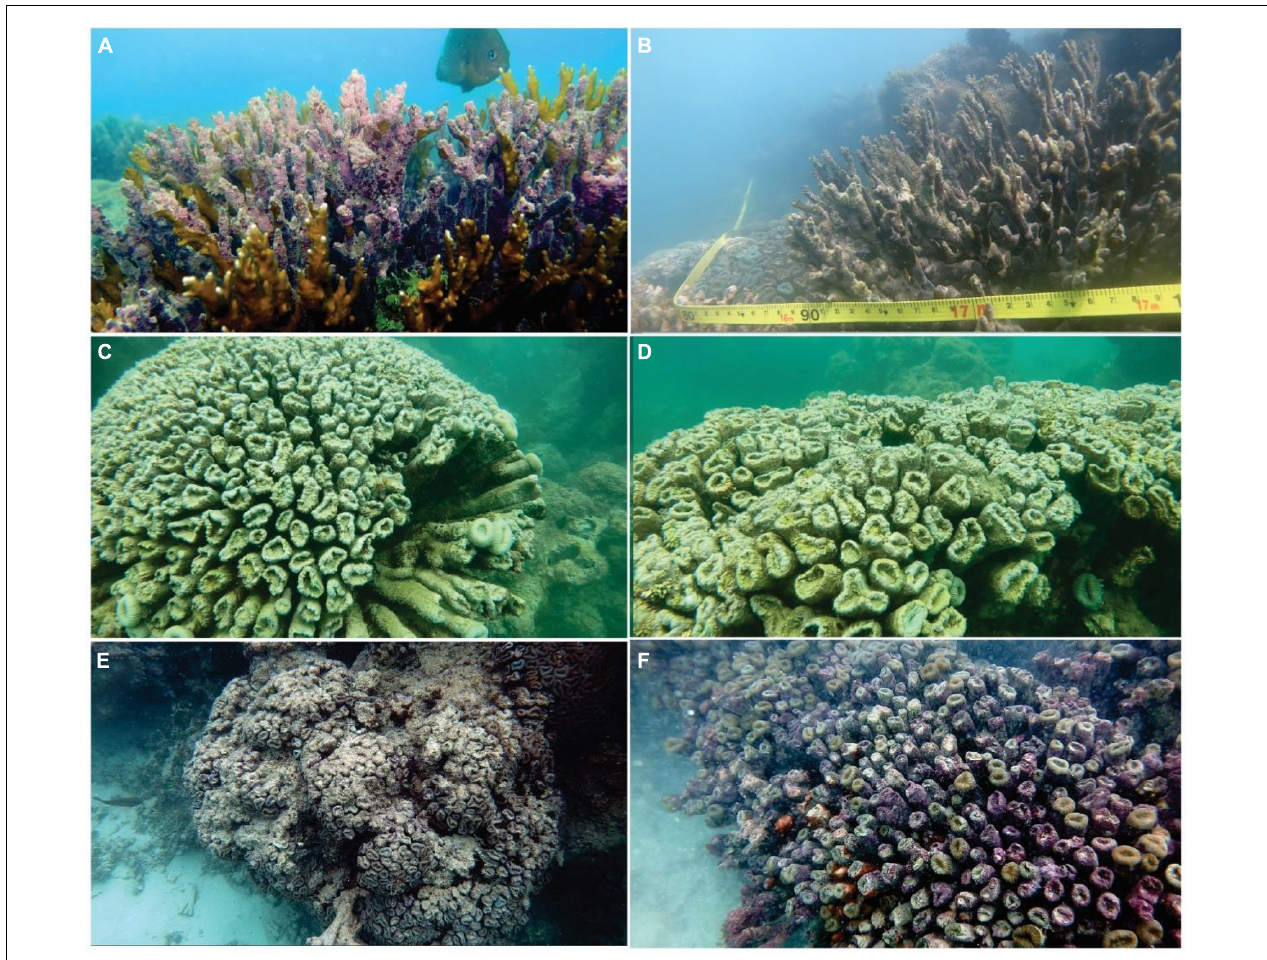
FIGURE 7 | Coral mortality records for Millepora alcicornis (A,B) and for the endemic Mussismilia harttii (C–F) at marine protected area (MPA) Costa dos Corais during post-bleaching period. Dead corals are brownish and covered by algae for (A,B) and coral polyps are pale and covered by sediment for (C–F) .